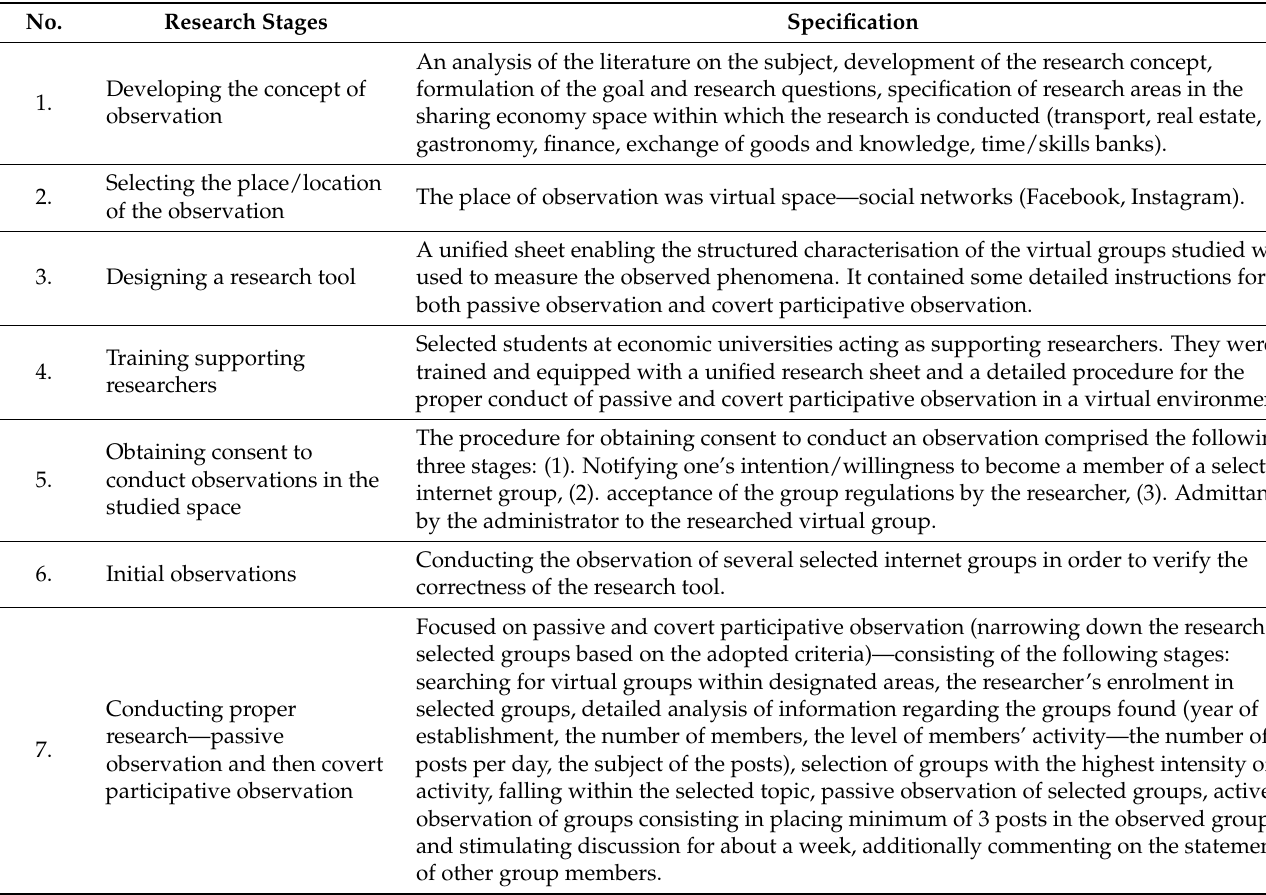
Table 3. Stages of the empirical research based on observation applied as a research